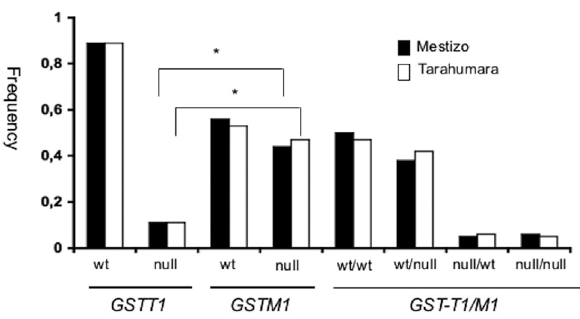
Figure 1 - Frequencies of GSTT1 and GSTM1 null genotypes in Mestizo (black bars) and Tarahumara individuals (white bars) from the northwest- ern region of Mexico. Wt: wild type. * p < 0.05.